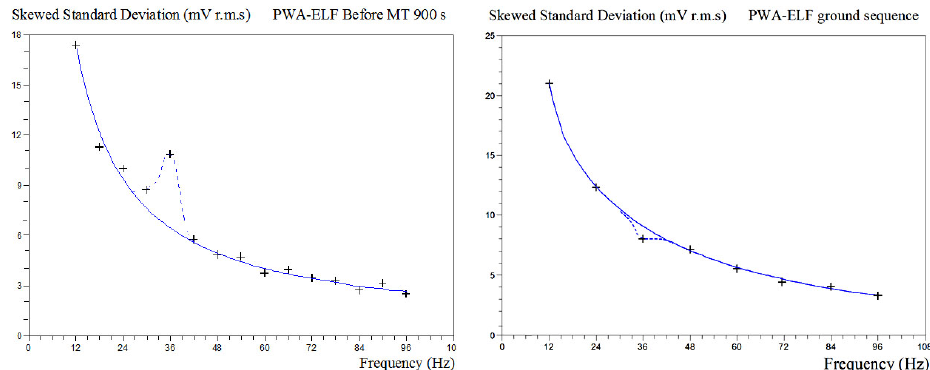
Fig. 5. Frequency variation of the normalized skewed standard deviation σ 0